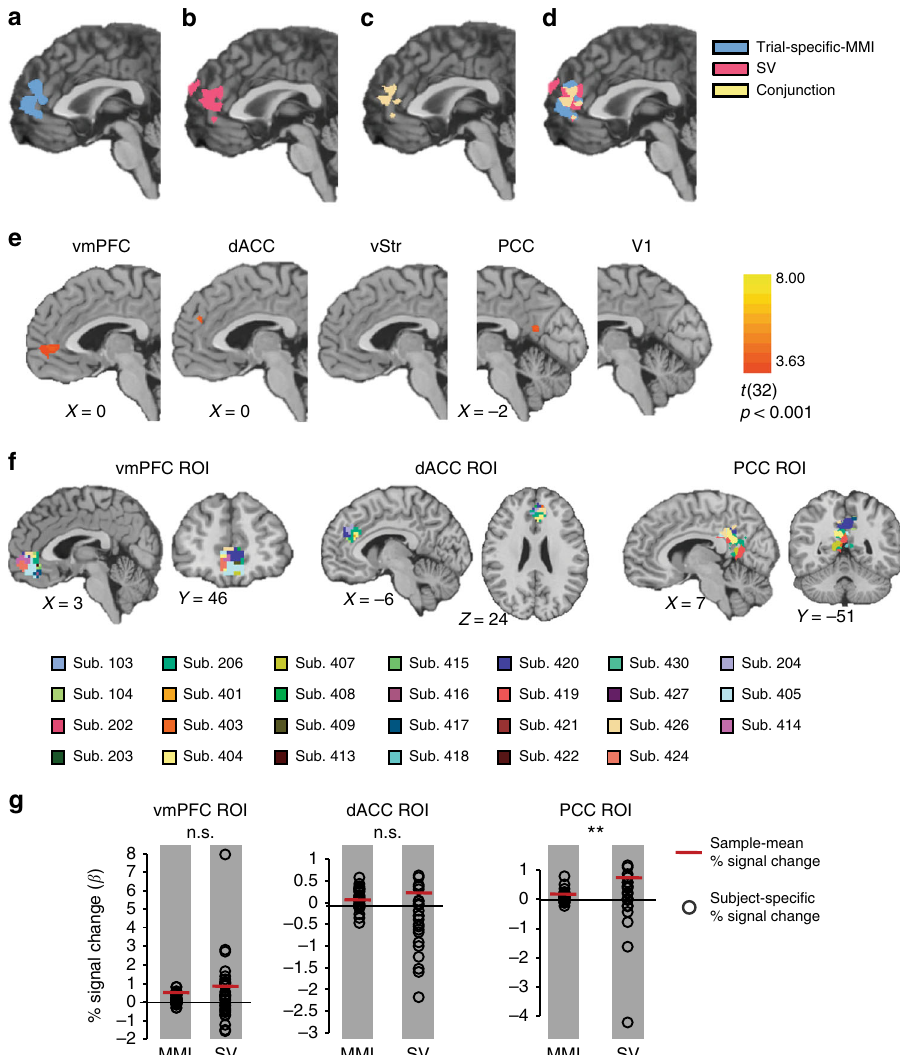
Fig. 5 Neuroimaging results. a – d Whole brain: Results of RFX GLM, n = 33, p < 0.0005, cluster-size correction, x = 0 (MNI coordinates). Model regression: BOLD ¼ β 0 þ β 1 RT þ β 2 MMI trial specific þ β 3 SV þ β 4 priceratio þ β 5 endowment . Six additional motion-correction regressors were included as regressors